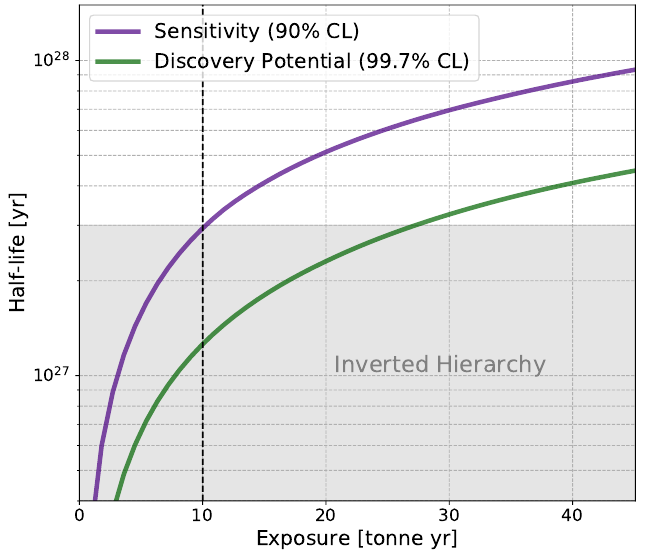
Figure 10 . Projected sensitivity to the 136 Xe 0 νββ half-life and discovery potential for a NEXT tonne-scale experiment located at LNGS. The shaded region represents the inverted hierarchy under the assumption of light Majorana neutrino exchange. In order to reach exposure above 10 t yr (indicated with a dashed line in the plot), a multi-module approach could be considered, as described in the